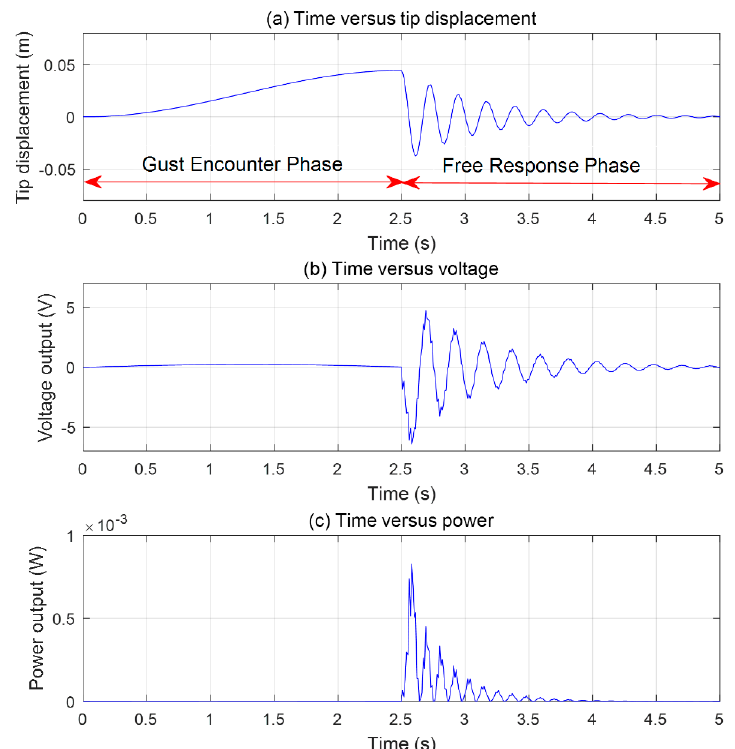
Figure 4. Time histories of ( a ) displacement at leading edge of wing tip; ( b ) voltage output at the leading edge symmetric PZTs layers of wing root; ( c ) power output at the leading edge symmetric PZTs layers of wing root. Flight working condition: 40 m/s chordwise flow speed; 5 m/s “one-minus-cosine” discrete gust intensity; 100 m gust wavelength.